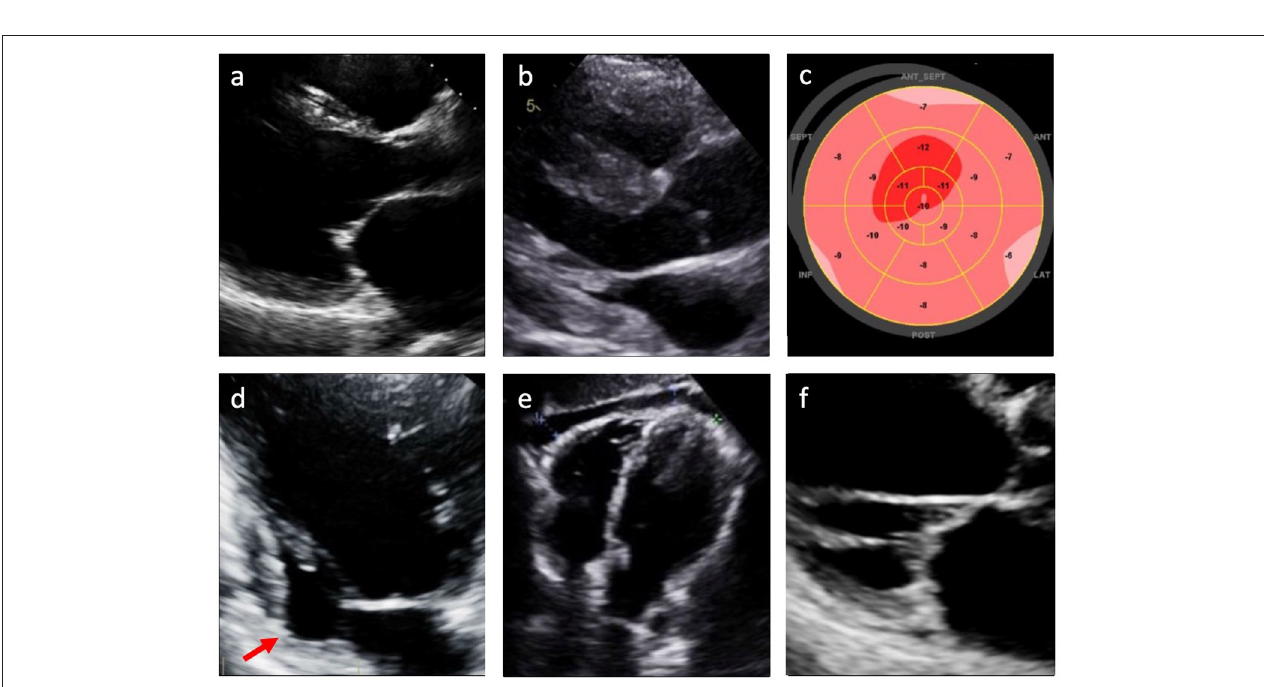
FIGURE 2 | Echocardiographic findings in cardiac sarcoidosis. (a) Left ventricular dilatation; (b) Left and/or right ventricular hypertrophy; (c) Reduced global longitudinal strain (GLS); (d) Left ventricular wall aneurysm (arrow); (e) Pericardial effusion; (f) Valvular thickening or dysfunction.